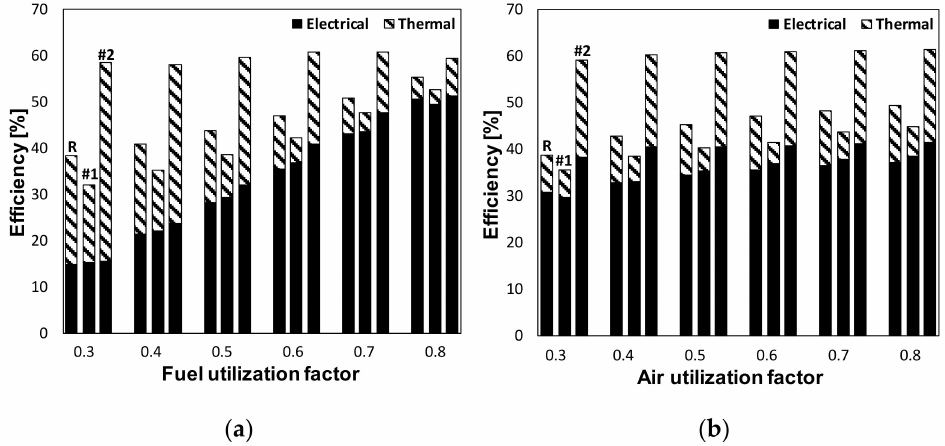
Figure 8. Efficiency of each configuration with various ( a ) fuel and ( b ) air utilization factors. (R: reference system, #1: AOGR #1 system, #2: AOGR #2